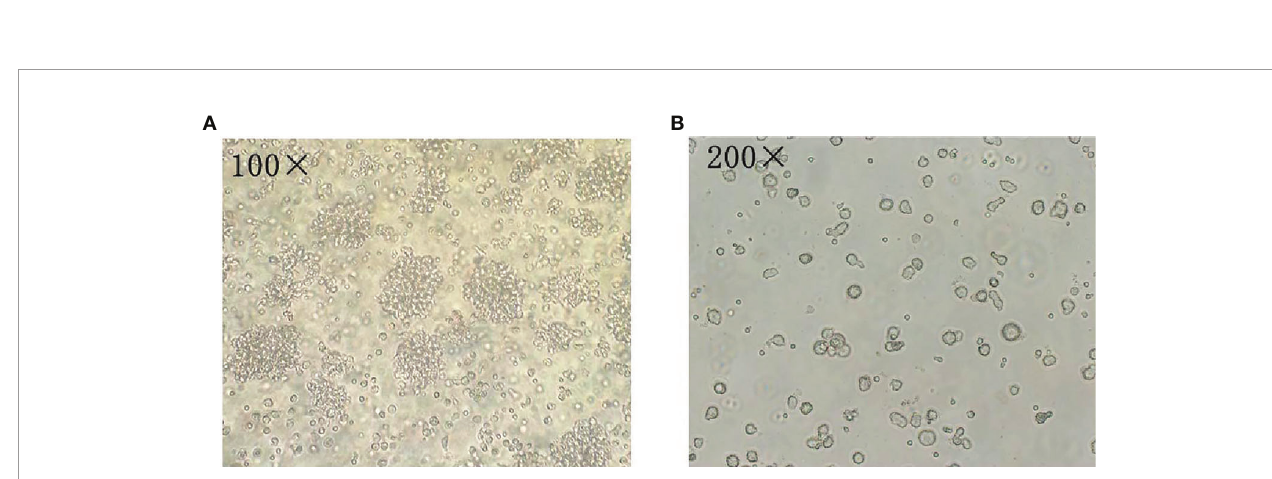
FIGURE 2 | Analysis of mDCs using microscopy. (A) The mDCs was observed by microscope after 7 days of culture (100×). (B) The mDCs was observed by microscope after 7 days of culture (200×).